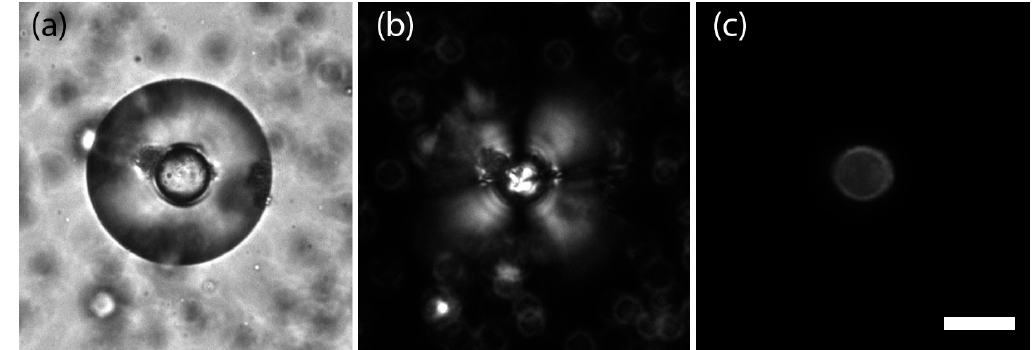
Figure 4 . Optical microscopy images of the same droplet with a single quantum dot hollow capsule inside. ( a ) Bright-field image, ( b ) cross-polarized image, and ( c ) fluorescence image, showing quantum dots only. Scale bar = 20 μ m .